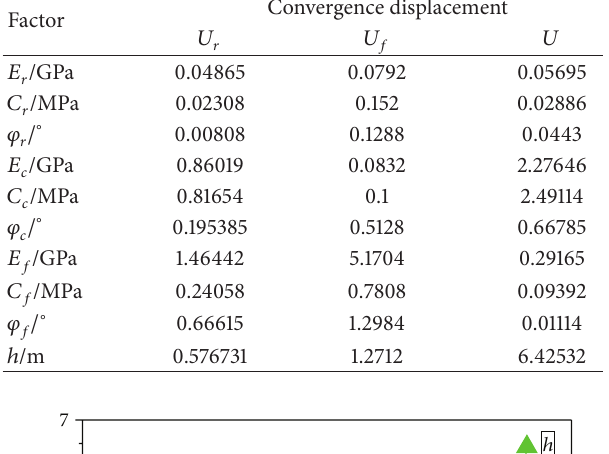
Table 2: Calculating results of sensitivity coefficient.